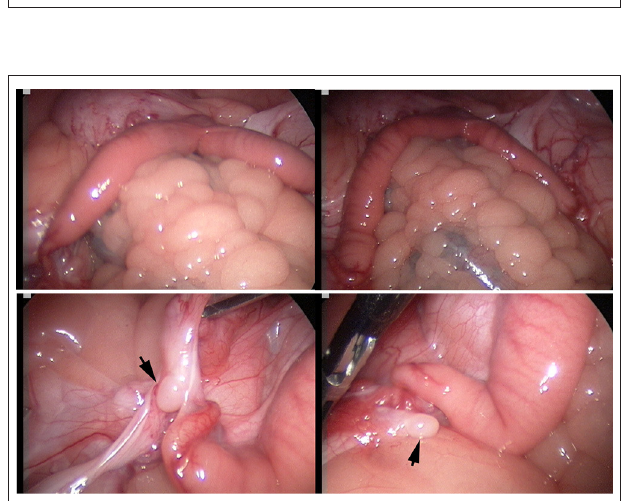
FIGURE 3 | Laparoscopic evaluation of the reproductive tract: Top: infantile flaccid uterus, bottom: inactive small ovaries (arrows) with a smooth surface and no visible